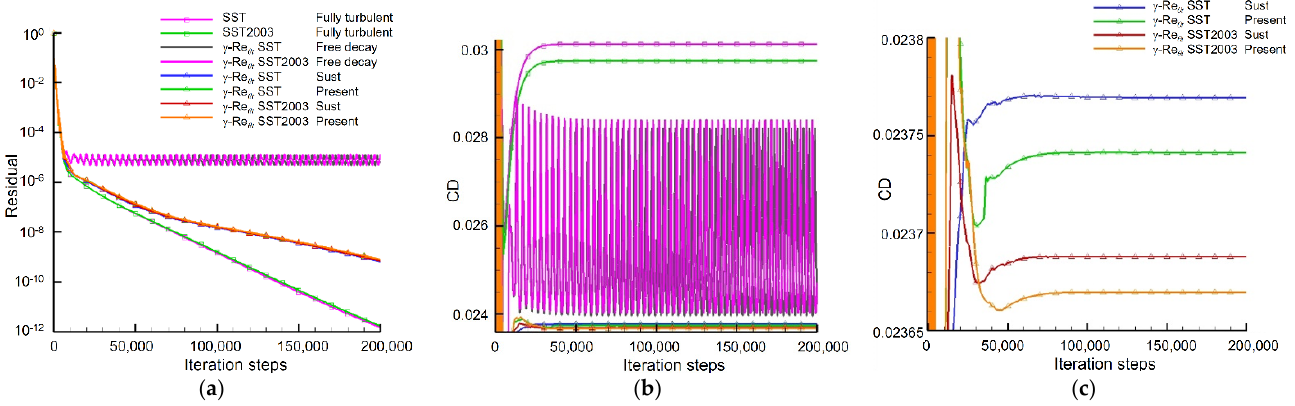
Figure 2. The convergence history for different turbulence/transition models. ( a ) Convergence history. ( b ) Drag coefficient vs. iteration steps. ( c ) Drag coefficient for different models.